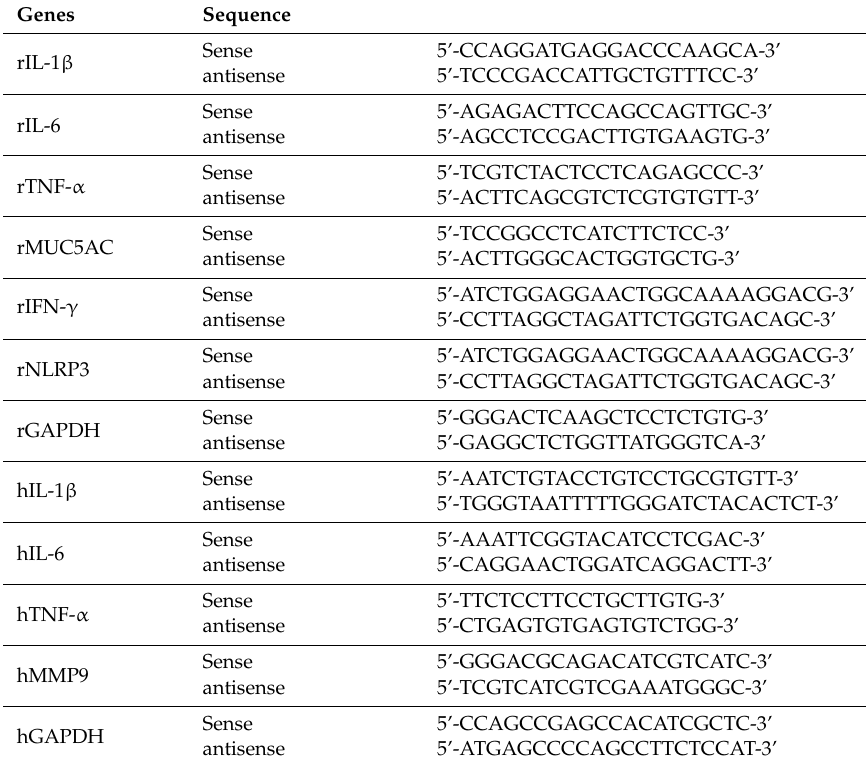
Table 1. Realtime PCR primer